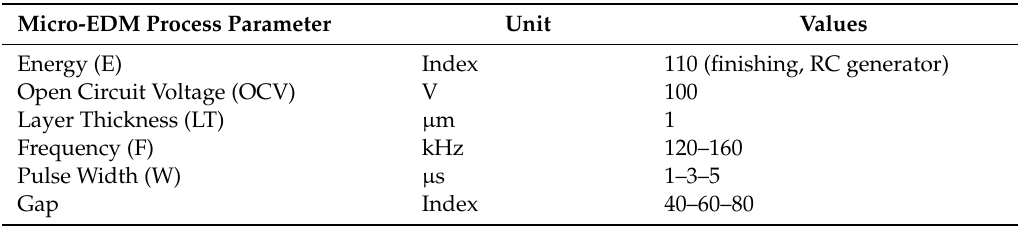
Table 1. The micro-electro discharge machining (EDM) milling process parameter settings.